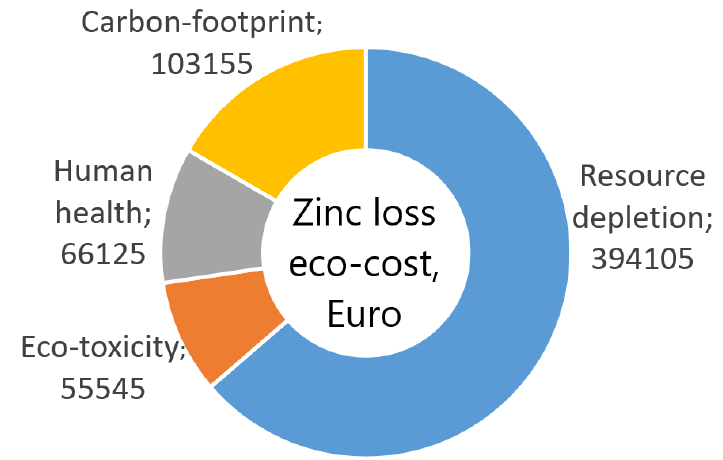
Figure 17. Costs generated by the loss of zinc in the production of 100,000 tons of steel wire.